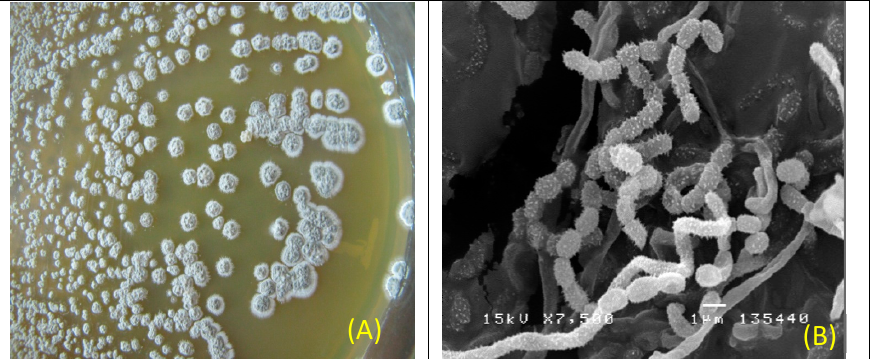
Figure 1. Colony morphology ( A ) and scanning electron microscope showing the spore-chain morphology and spore-surface ornamentation of the endophytic actinomycete strain MPT42 grown on ISP2 agar medium for 14 days at 28 ◦ C at a magnification of 7500 × ( B